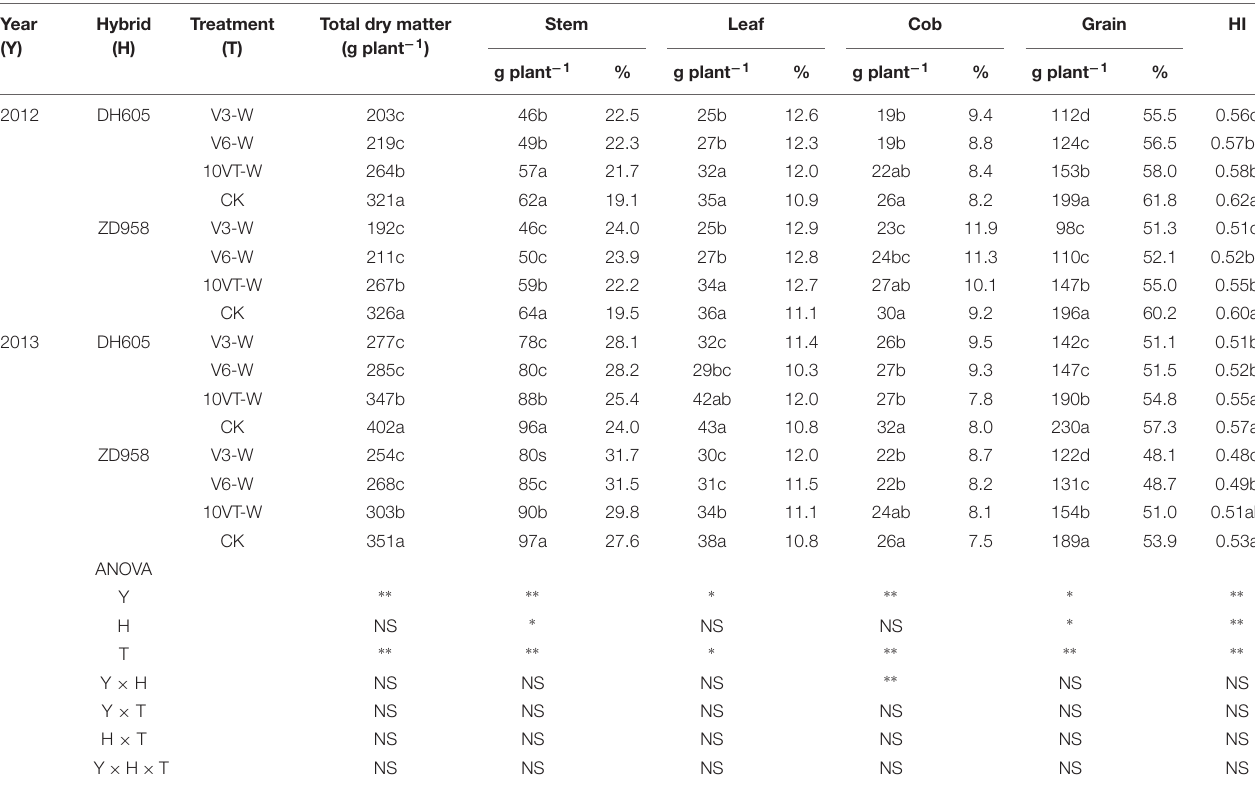
TABLE 3 | Effect of waterlogging on dry matter accumulation (g plant − 1 ) and distribution (%) of maize at maturity stage. Year Hybrid Treatment (Y) (H)